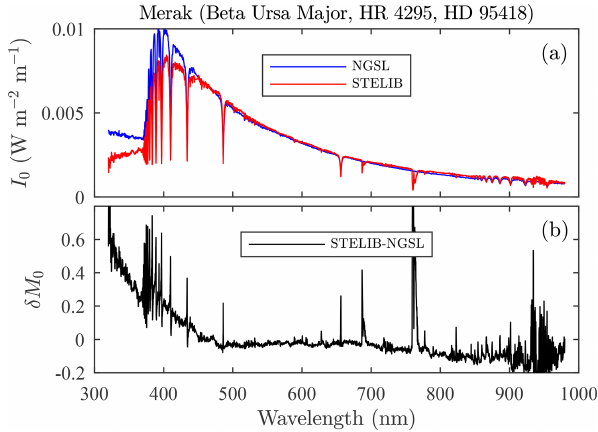
Figure 11. Spectrophotometric comparison of the STELIB cata- logue with respect to the HST NGSL (a) . Important bias are seen in the UV, and a much weaker bias is seen in the IR (b)